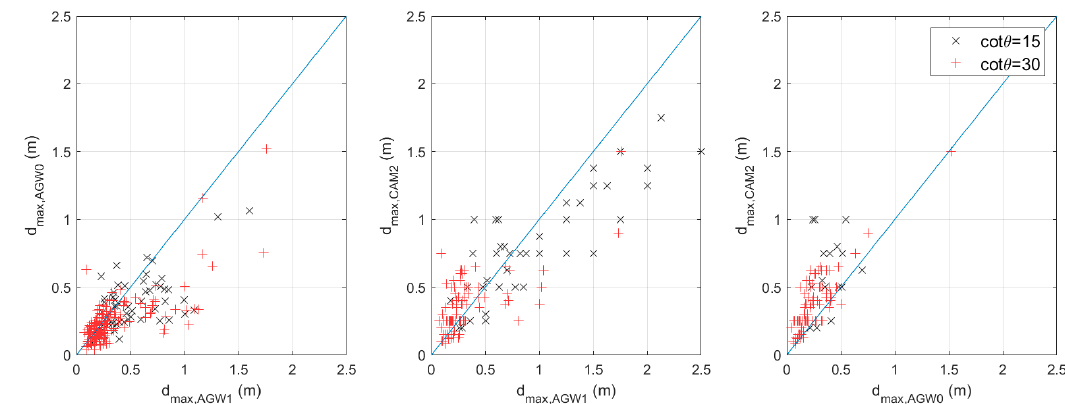
Figure 7. Lateral view with high-speed camera (CAM2).